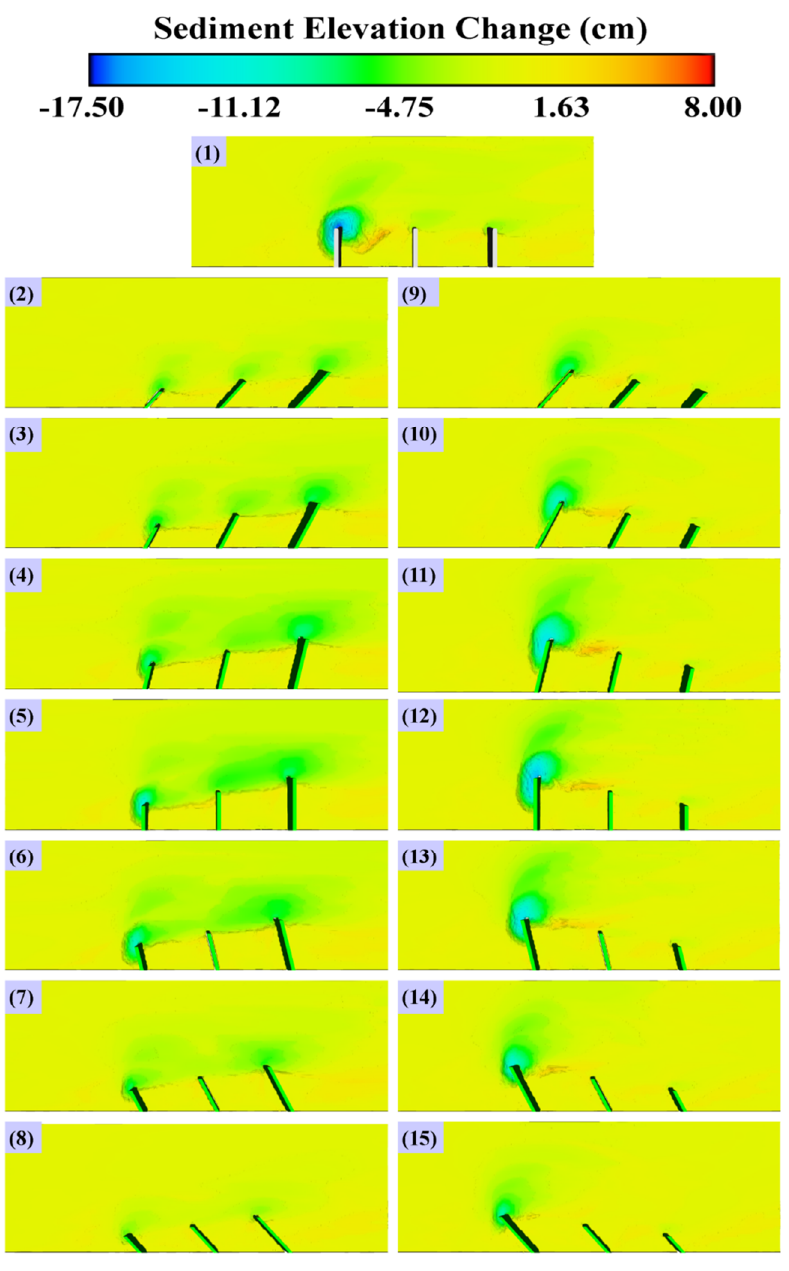
Figure 12. Scour variation under simulations 1–15.